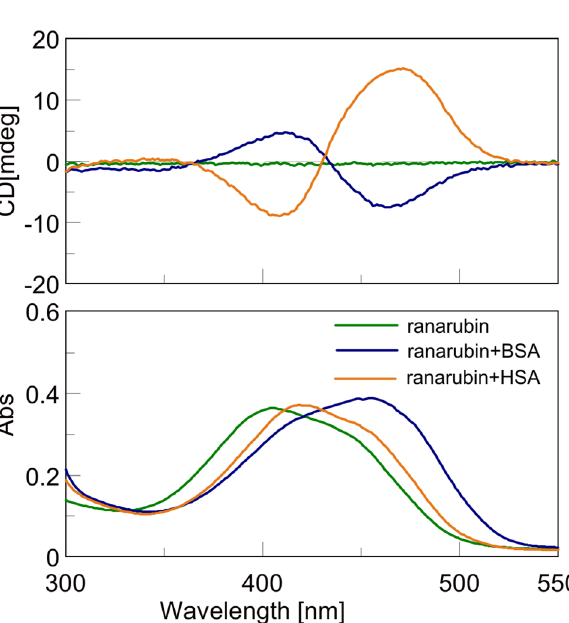
Figure 4. Electronic CD and absorption spectra of bilirubin-10-sulfonate (ranarubin). Bilirubin-10- sulfonate was measured in a mixture with BSA or HSA. Bilirubin-10-sulfonate:serum albumin (molar concentration) = 1:1, measured in v H 2 O, concentration of bilirubin-10-sulfonate = 1.2 × 10 –5